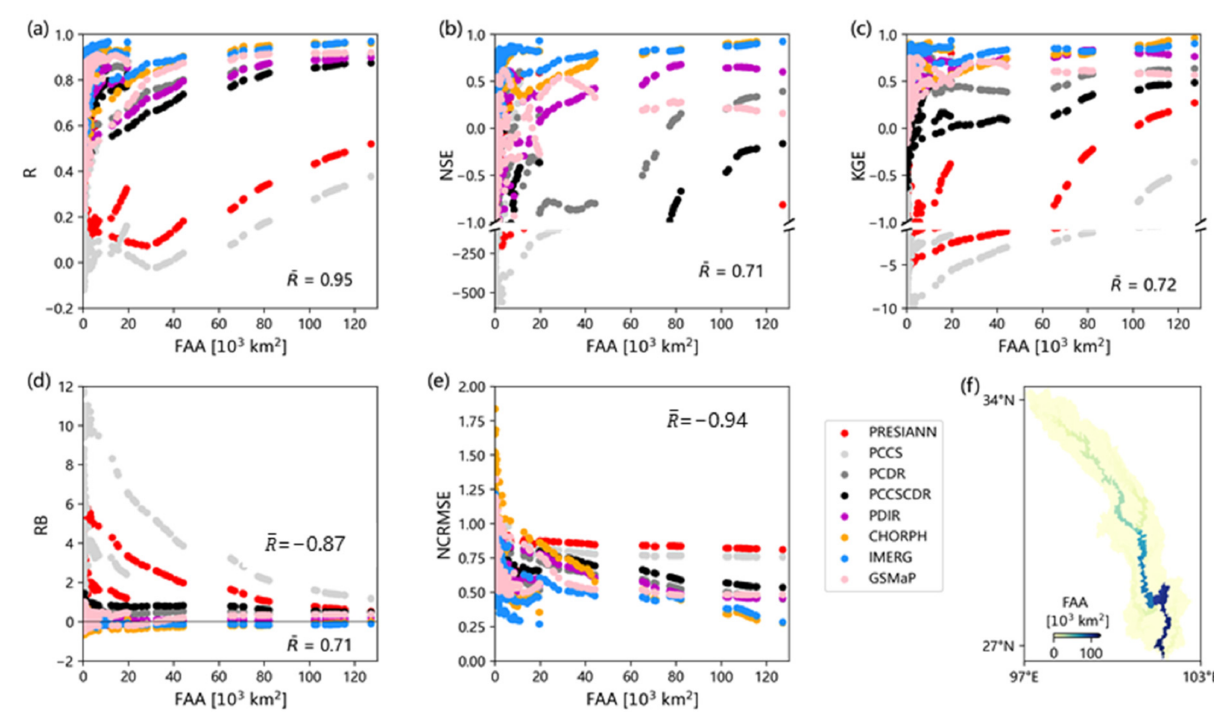
Figure 6. Hydrological simulation performance metrics ( a – e ) of eight SPEs as a function of the flow accumulation area (FAA). ( f ) The distribution of the flow accumulation area (FAA) in the YLJ